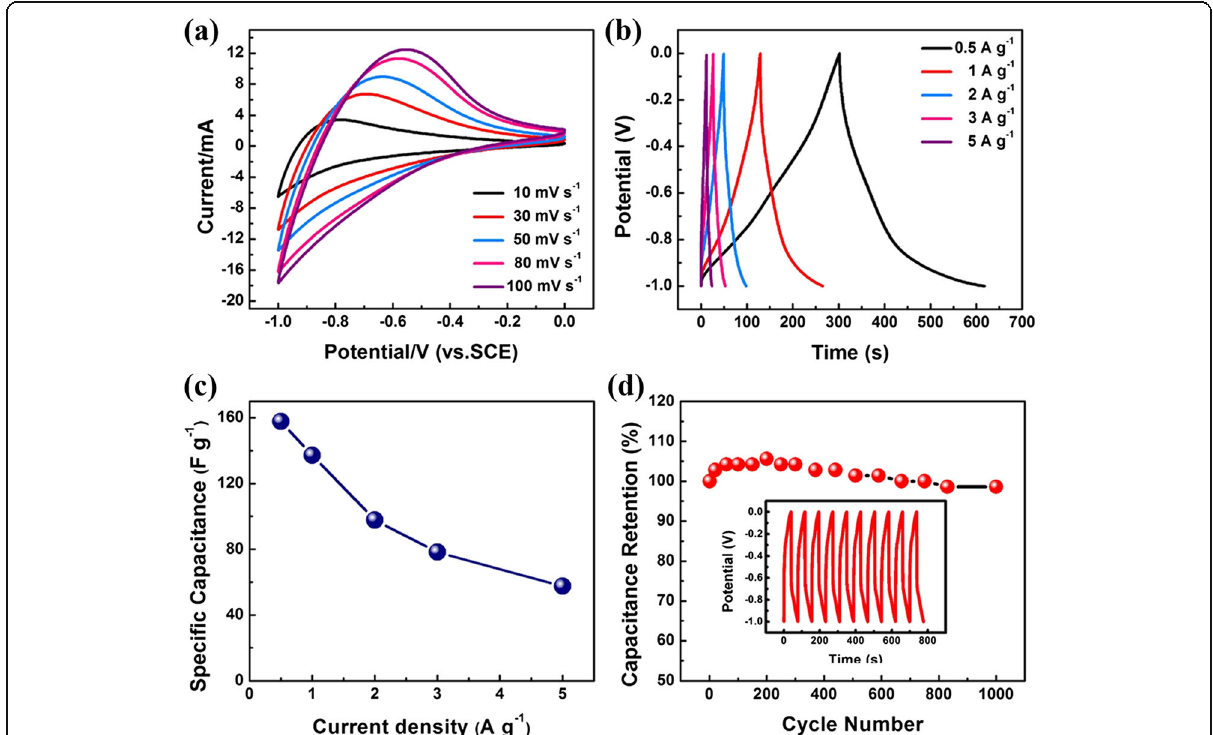
Fig. 3 a CV curves of Diatomite@FeOOH measured at different scan rates. b CC curves of Diatomite@FeOOH measured at different current densities. c Specific capacitance measured at different current densities. d Cycling performance of the electrode at a current density of 1 A g − 1 (the inset shows charge-discharge curves of the last 10